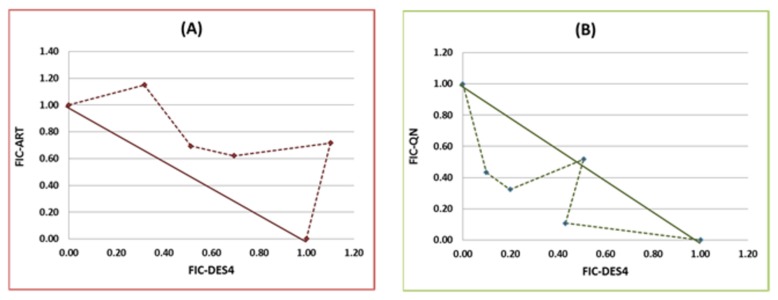
Isobolograms showing interactions of DES4 with Artemetherand Quinine, respectively.(A): DES4 vs Artemether (ART); (B): DES4 vs Quinine (QN).